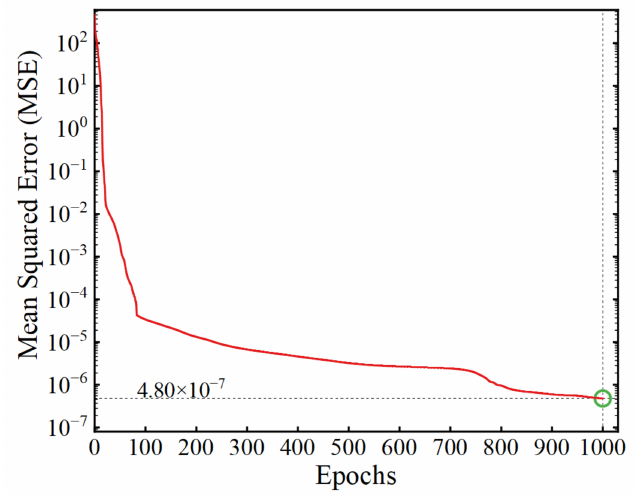
Figure 11. The variation of loss function with the increasing of epochs.